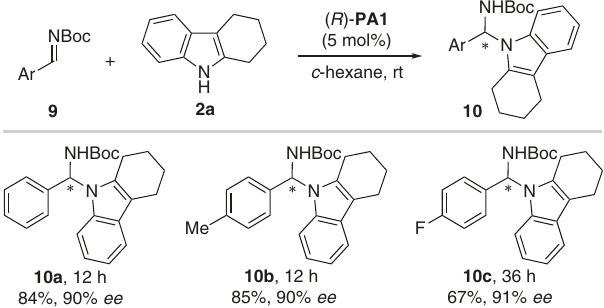
Fig. 8 N-Benzylation of indoles. Reaction conditions: 9 (0.05 mmol), 2a (0.06 mmol), ( R )- PA1 (5 mol%), c -hexane (1.0 mL),